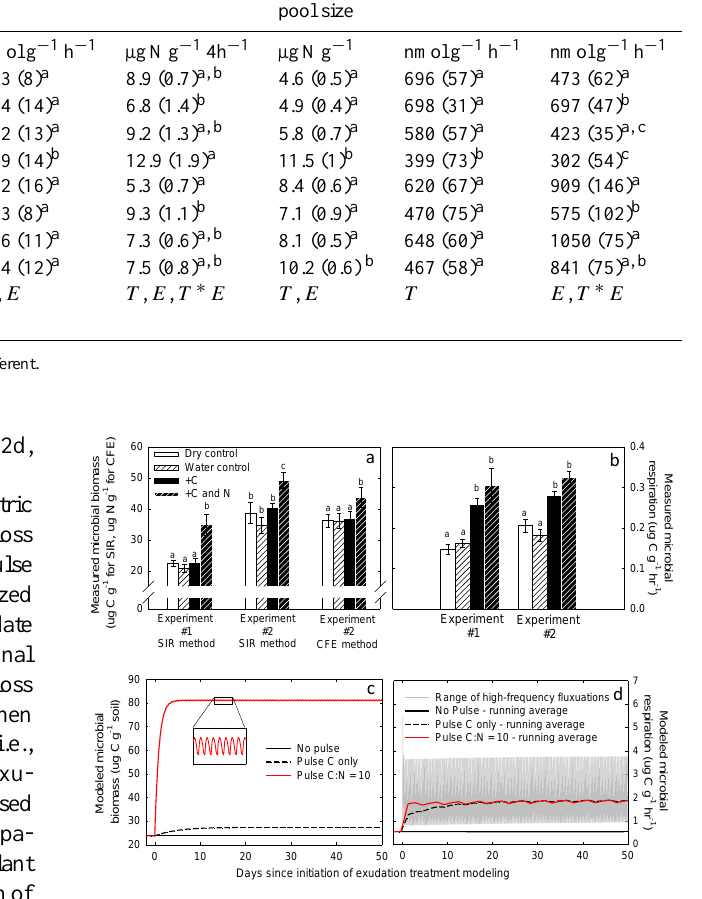
Table 2. Measured activity of soil exoenzymes and availability of soil amino acids in response to exudate mimic delivery to intact forest soils in the field. Values reflect the mean ( ± SE) of 10 replicates. T indicates a significant effect of exudation treatment, E indicates a significant difference between the two experiments, and T ∗ E indicates a significant interaction. Enzymes that decompose low molecular weight substrates Enzymes that decompose high molecular weight substrates Experiment